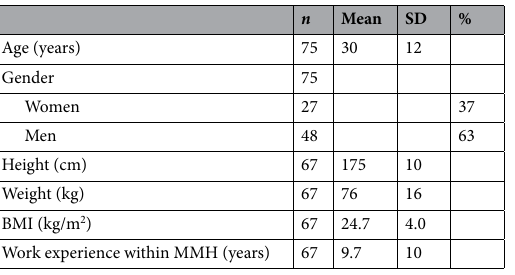
Table 3. Participant characteristics. n number, SD standard deviation, %